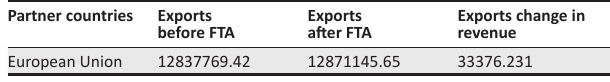
TABLE 7: Impact of the European Union Free Trade Agreement on South Africa exports (US$ 1000). Partner countries Exports before FTA